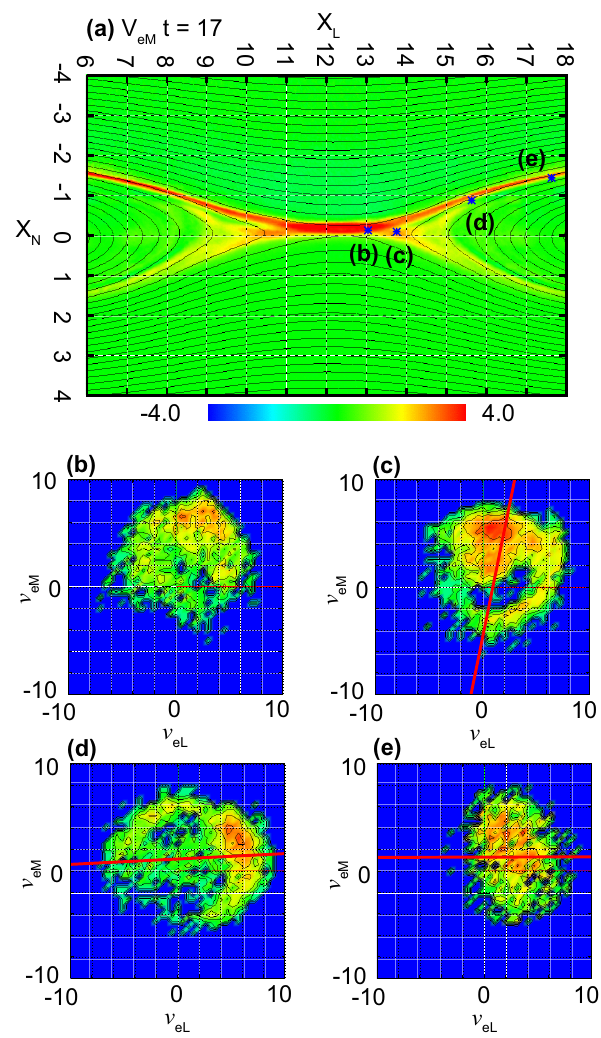
Figure 9 Fig. 9. The origin of the electron beam along the separatrix on the magnetosphere side. (a) 2-D contour of V eM . (b) ∼ (e) Elec- tron distribution functions on the v N =0 plane. The sampling loca- tions are ( x N , x L ) =( − 0.13, 13), ( − 0.1, 13.75), ( − 0.9, 15.6), and ( − 1.5, 17.6). The red lines in Fig. 9c ∼ e is the direction of the local magnetic field at each location. Each red line in Fig. 9c ∼ e is given by v M =( B M / B L ) × (v L − V E × B ,L ) + V E × B ,M , where B M , B L , V E × B ,L , and V E × B ,M are the values at each sampling loca- tion. The slope of the red line is the direction of magnetic field in L- M plane at each location. The point ( v L , v M ) =( V E × B ,L , V E × B ,M ) is the origin for an observer that is co-moving with the field